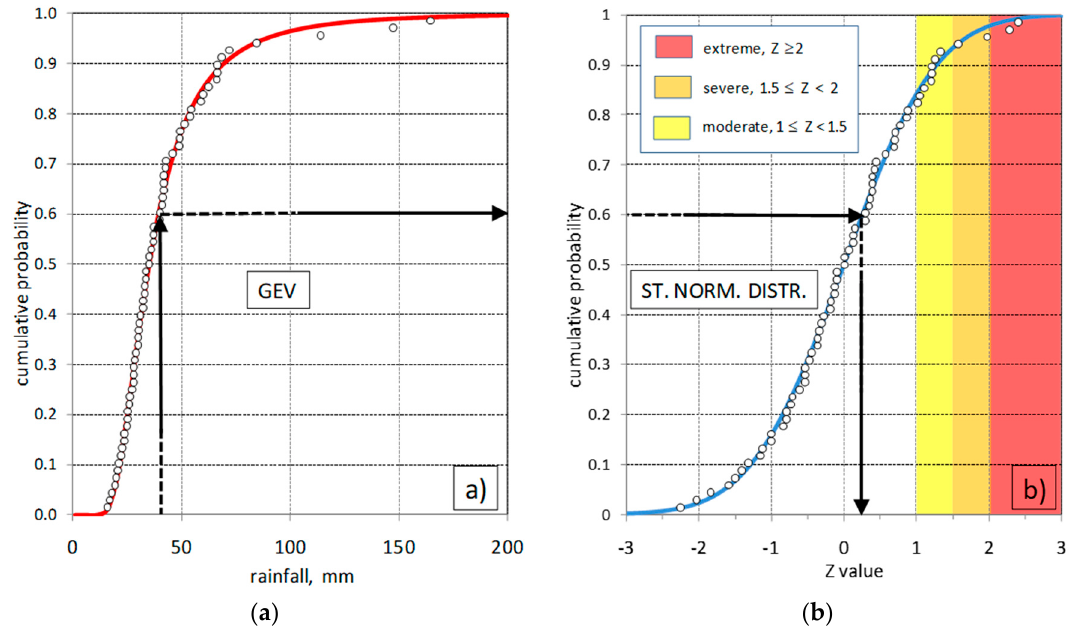
Figure 6. ( a ) Six-hour rainfall data series plotted by the Weibull formula and fitted by the Generalized Extreme Value (GEV) distribution; ( b ) cumulative probability transformed into the Z value of the standard normal distribution transformation.